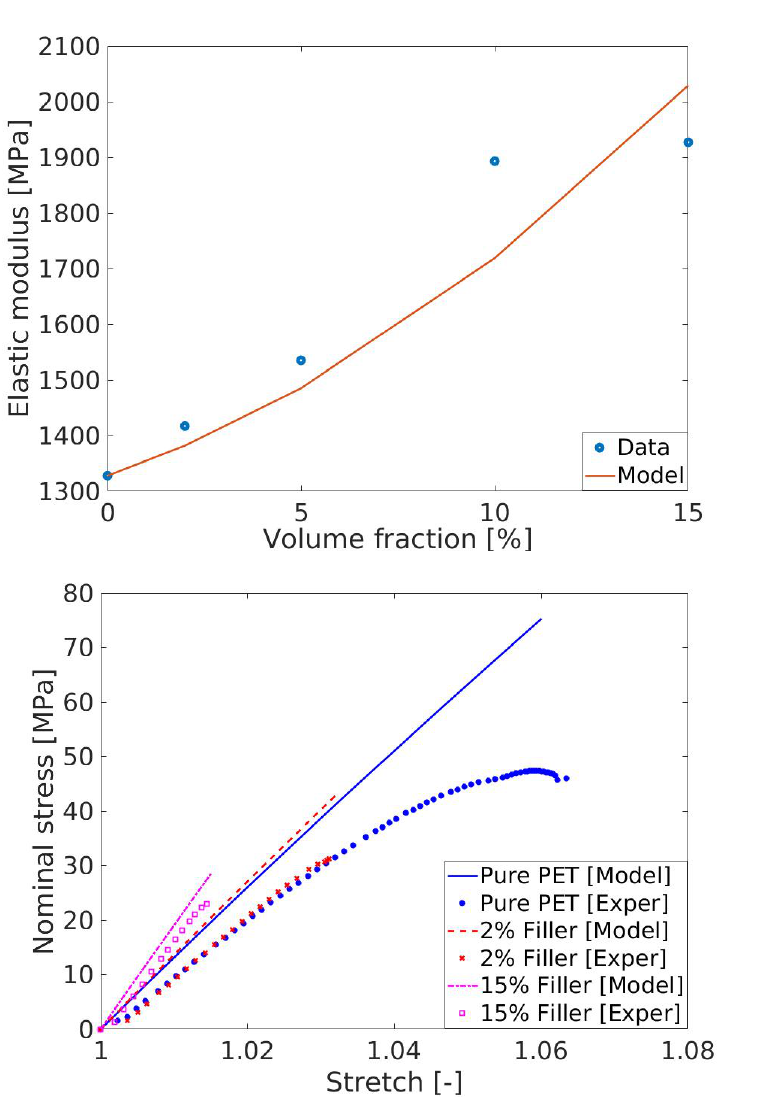
Figure 8. ( Top ) Model fitting of elastic moduli at various fraction of fillers; and ( Bottom ) model prediction with the linear Neo-Hooke model. NH model yields unsatisfactory fitting with the experimental data.